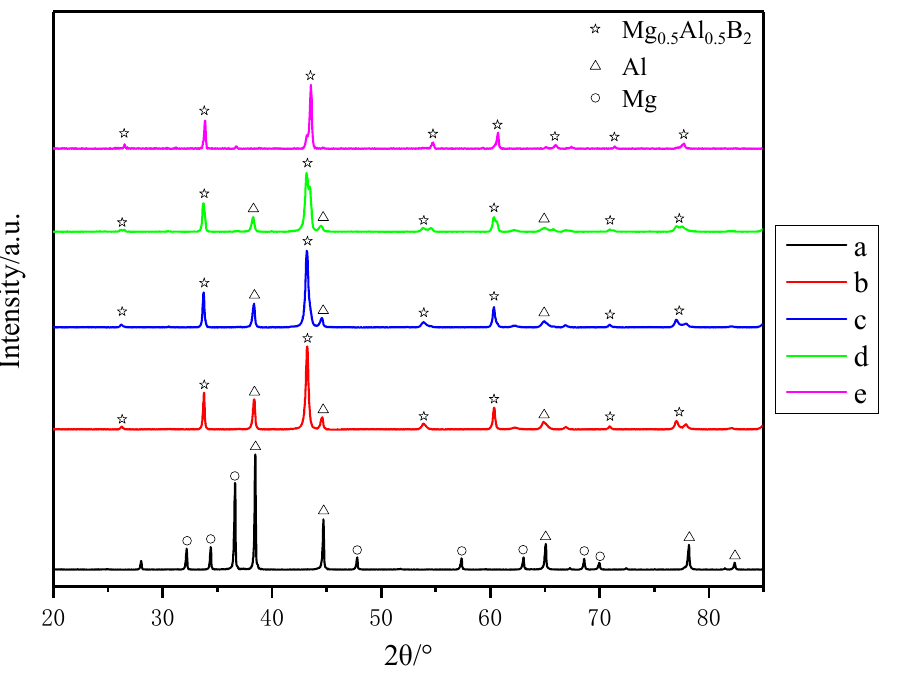
Figure 1. XRD patterns of samples sintered at different temperatures for 2 h: ( a ) room temperature, ( b ) 700 °C, ( c ) 800 °C, ( d ) 900 °C and ( e ) 1000 °C . Table 1. Content of Mg 0.5 Al 0.5 B 2 phase and residual metals phase in the samples sintered for 2 h at different temperatures